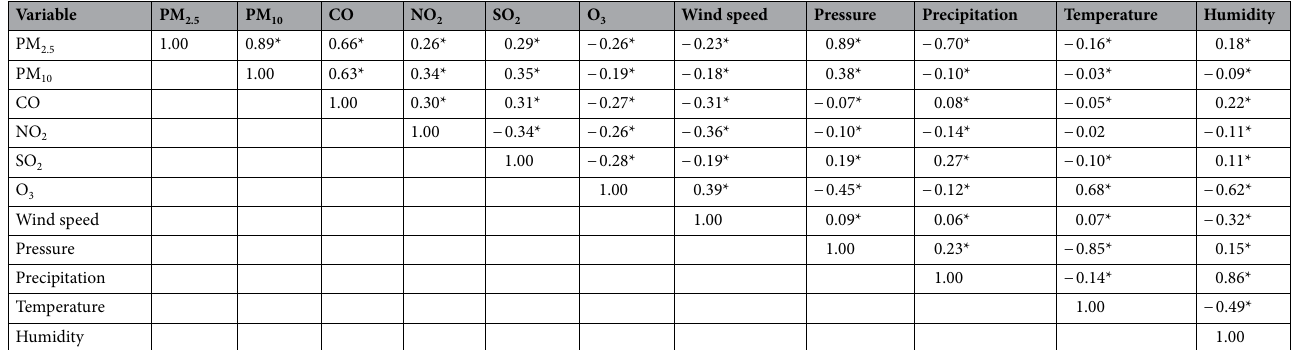
Table 2. Pearson linear correlation coefficient between the concentrations of six types of air pollutants measured at national control point and five meteorological parameters measured at self-built point (Band * indicates significant correlation at a significant level of